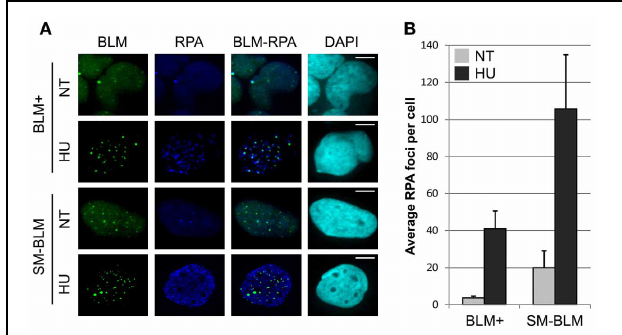
FIGURE 2 | Excess RPA accumulates at stalled replication forks in SUMO-mutant BLM cells. (A) Immunofluorescence images of BLM + and SM-BLM cells untreated (NT) or treated with 0.5mM HU for 24h (HU) and stained for RPA. Bars indicate 10 μ m. (B) Graphical representation of mean numbers of RPA foci. Three independent experiments were carried out for each of two BLM + and two SM-BLM clones. Error bars represent the standard deviations of the results of each experiment. There were significantly more RPA foci in SM-BLM cells compared to BLM + cells ( p < 0 . 001) and HU treatment induced significantly more RPA foci in both cell lines ( p < 0 . 001). Interaction was also observed indicating that the difference in effect of HU treatment on the two cell lines is significant ( p int = 0 . 002). P -values were calculated using mixed effects linear models as described in Materials and Methods.